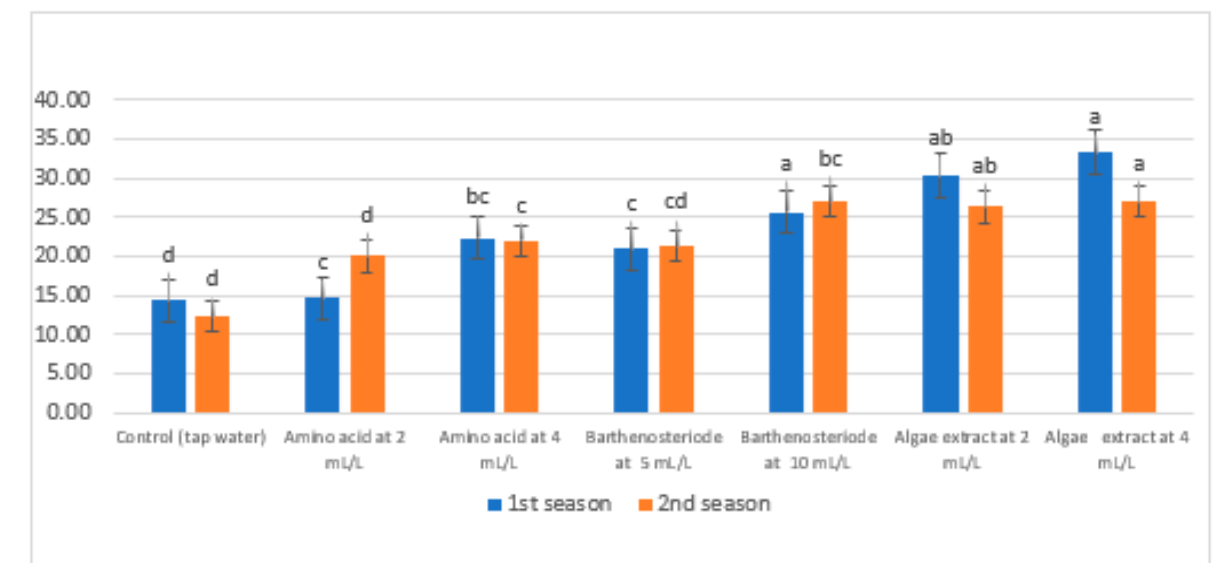
Figure 10. Effect of various biostimulant treatments on Mn(ppm)of chia ( Salvia hispanica L.) plant during the 2019–2020 and 2020–2021 seasons. For the same column, means followed by the same letter are not statistically different, according to the Tukey multiple range test